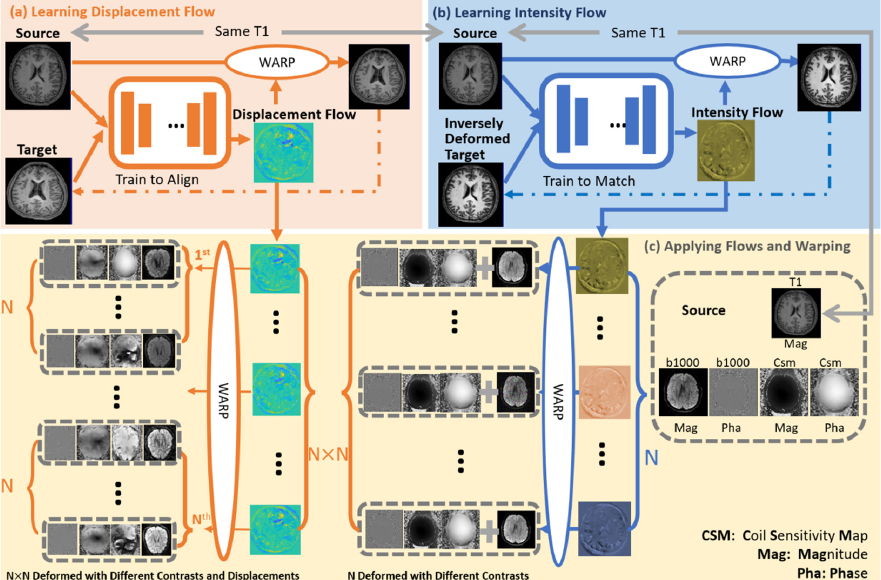
Figure 1. The architecture of the proposed MAGIC-K Net. The displacement and intensity flow fields were learned from pairs of T1w images. Then, the intensity and displacement flow fields were applied to the magnitude and phase of DWI with b = 1000 s/mm 2 , generating data sets with different contrasts and anatomical structures.